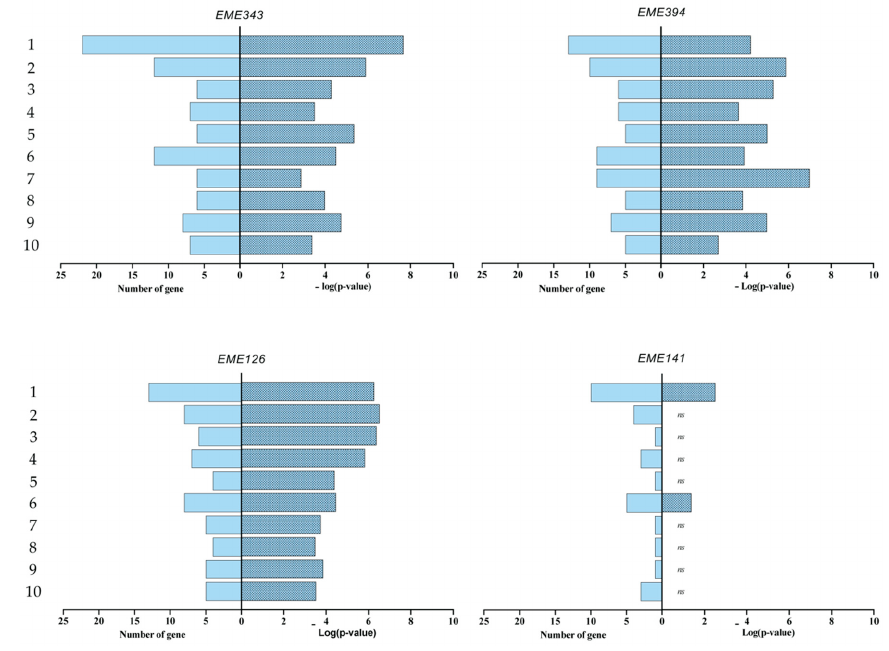
Figure 6. Number of genes significantly enriched in top molecular and cellular functions. Analysis was performed by using IPA. The area of the bubbles is proportional to the number of genes differentially expressed. Enrichment analysis of molecular and cellular functions are statistically significant when a p -value < 0.05. The p -values range from 1.15 × 10 − 2 to 1.29 × 10 − 13 .